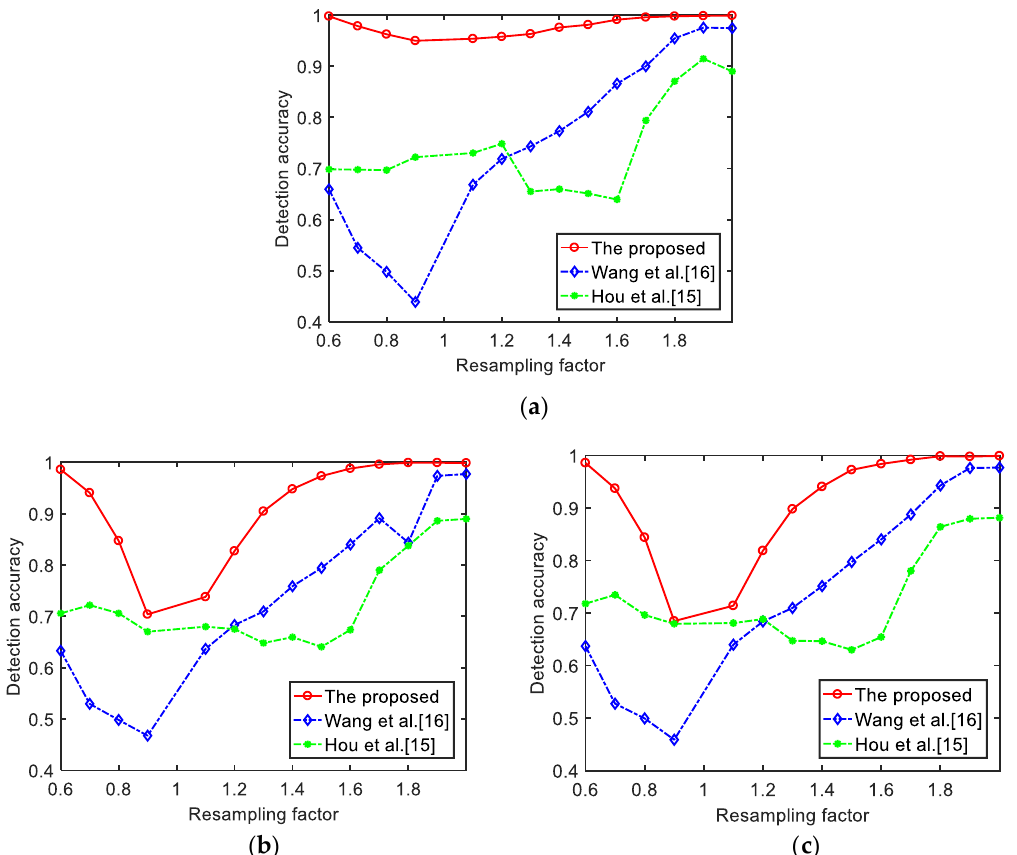
Figure 10. Influence of different compression rates on speech resampling detection. ( a ) The detection accuracy of the MP3 compression bit rate at 32 kbps; ( b ) the detection accuracy of the MP3 compression bit rate at 64 kbps; ( c ) the detection accuracy of the MP3 compression bit rate at 128 kbps.